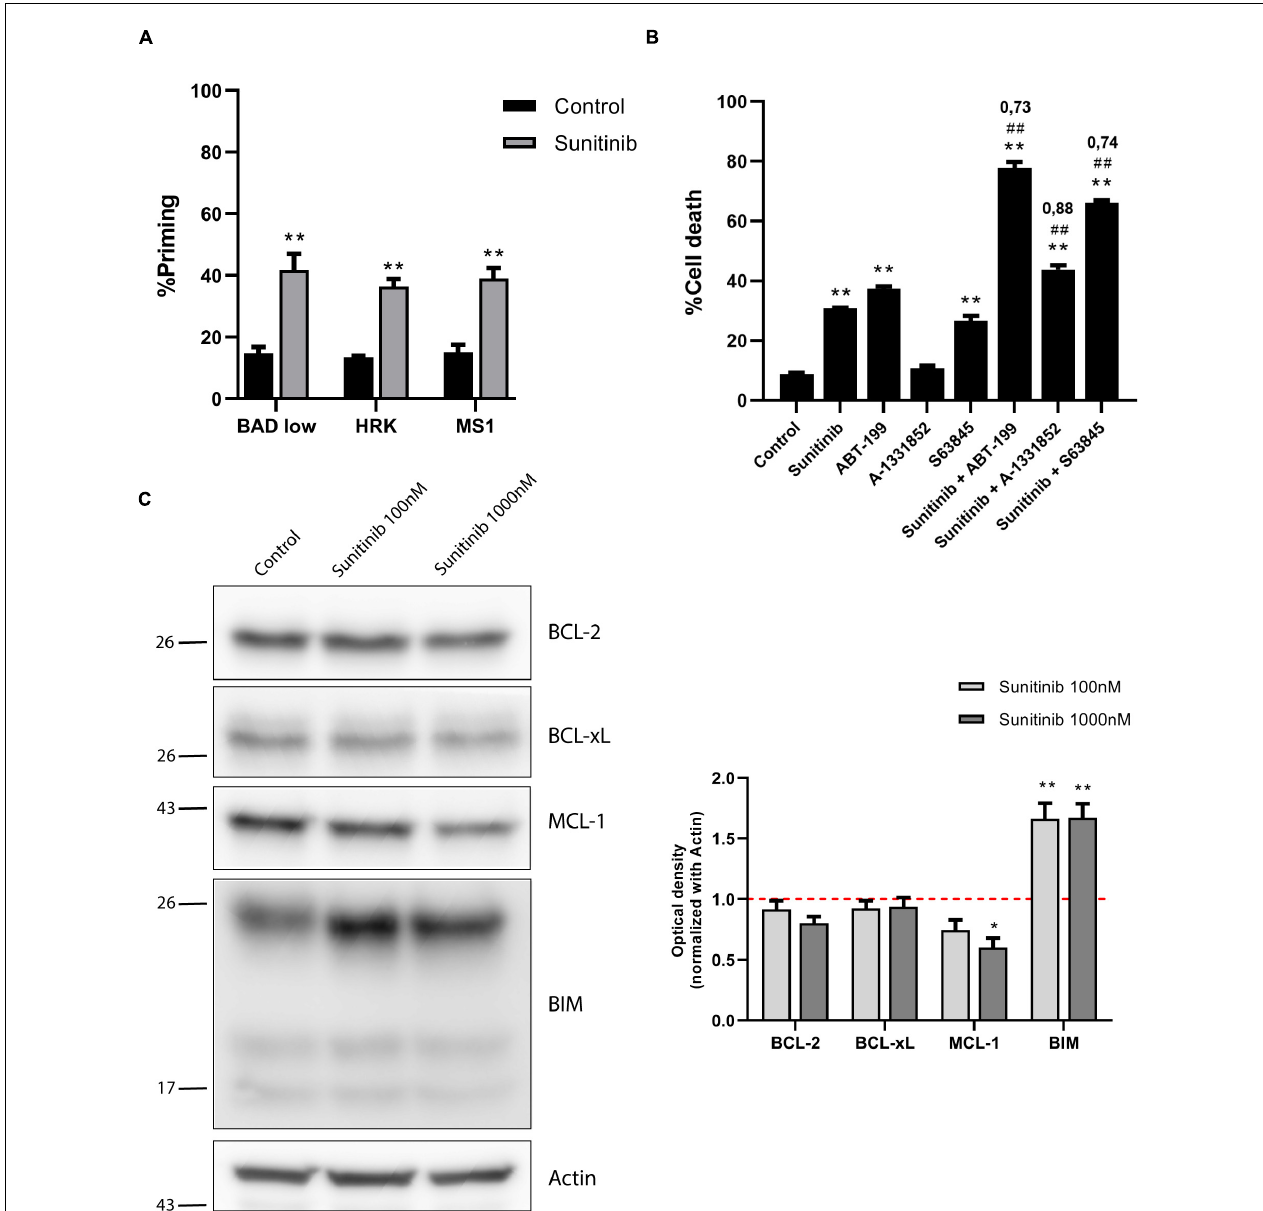
FIGURE 4 | Sunitinib synergizes with ABT-199 and S63845 in SEM cells but anti-apoptotic proteins are downregulated. (A) DBP results using sensitizers peptides to study anti-apoptotic dependence of BCL-2 and BCL-xL with BAD 0.1 µ M, BCL-xL with HRK 100 µ M and MCL-1 with MS1 10 µ M after 16 h of incubation with sunitinib 1,000 nM in SEM cell line. (B) Cytotoxicity assessed by Annexin V/DAPI staining after 96 h of sunitinib 100 nM, ABT-199 10 nM, A-1331852 100 nM and S63845 100 nM exposure in SEM cells. BH3 mimetics in combination with sunitinib were added 16 h after treatment. (C) Western blot analysis for anti-apoptotic and BIM proteins in SEM cells after 16 h of treatment with sunitinib 100 nM and sunitinib 1,000 nM. Quantification of optical density for each protein was normalized to actin, and fold-change was calculated comparing to protein expression in the control condition. All results are expressed as the mean ± SEM of at least three biologically independent replicates. Statistical significance was calculated using Student’s t -test compared to control condition and considering * p < 0.05 and ** p < 0.01. Significance was also calculated comparing combination conditions with both single agents and considering # p < 0.05 and ## p < 0.01. CI is indicated on top of every combination where CI < 1 indicates a synergistic